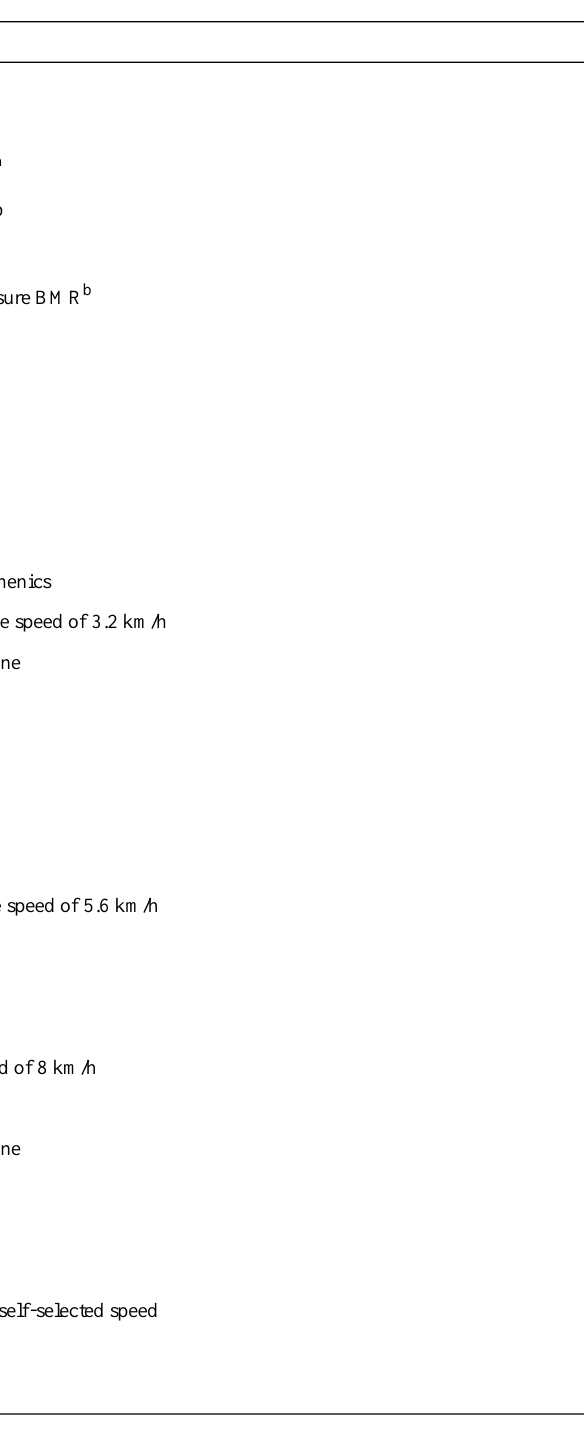
Table 2. Schedule of activities during the metabolic chamber